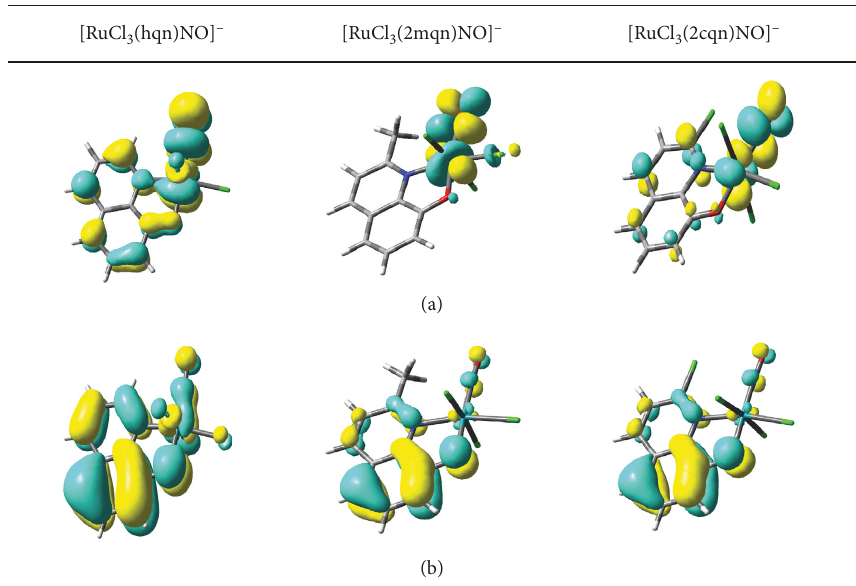
Figure 2: Contour diagrams of the calculated LUMO (a) and HOMO (b) of three complexes. Negative values of the wave function are represented in yellow.